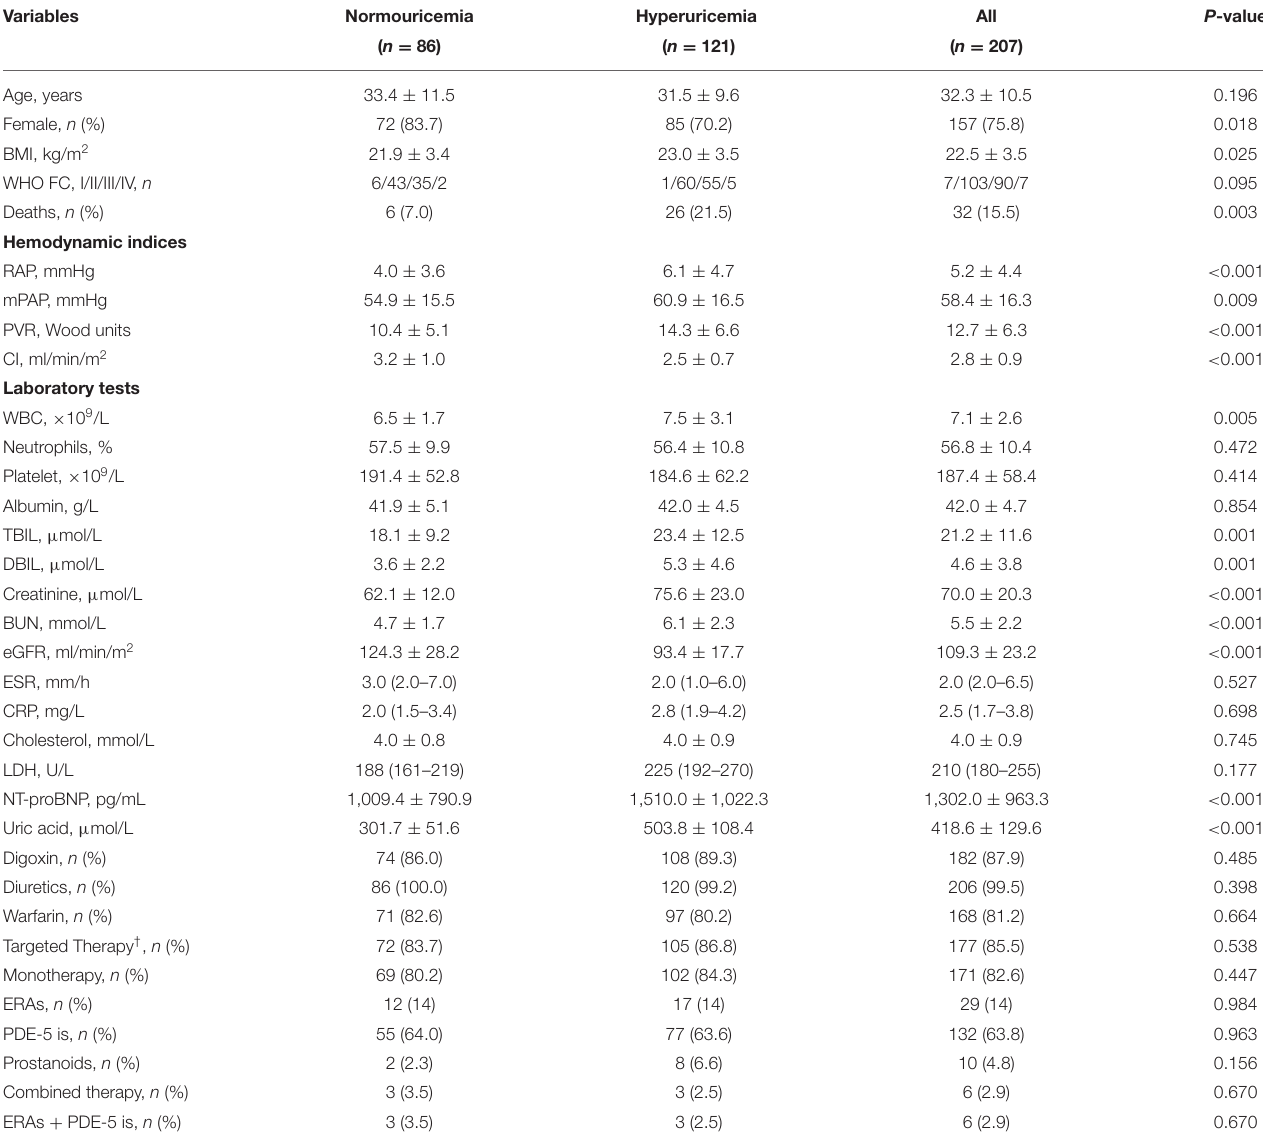
Values are expressed mean ± standard deviation or mean (interquartile range) or n%. BMI, body mass index; WHO FC, World Health Organization functional classes; RAP, right atrial pressure; mPAP, mean pulmonary artery pressure; PVR, pulmonary vascular resistance; CI, cardiac index; WBC, white blood cells; TBIL, total bilirubin; DBIL, direct bilirubin; BUN, blood urea nitrogen; eGFR, estimated glomerular filtration rate; ESR, erythrocyte sedimentation rate; CRP, C-reactive peptide; LDH, lactate dehydrogenase; NT-proBNP, N-terminal pro-B type natriuretic peptide; ERAs, endothelin receptor antagonists; PDE-5 is phosphodiesterase-5 inhibitors. † At index hospitalization.